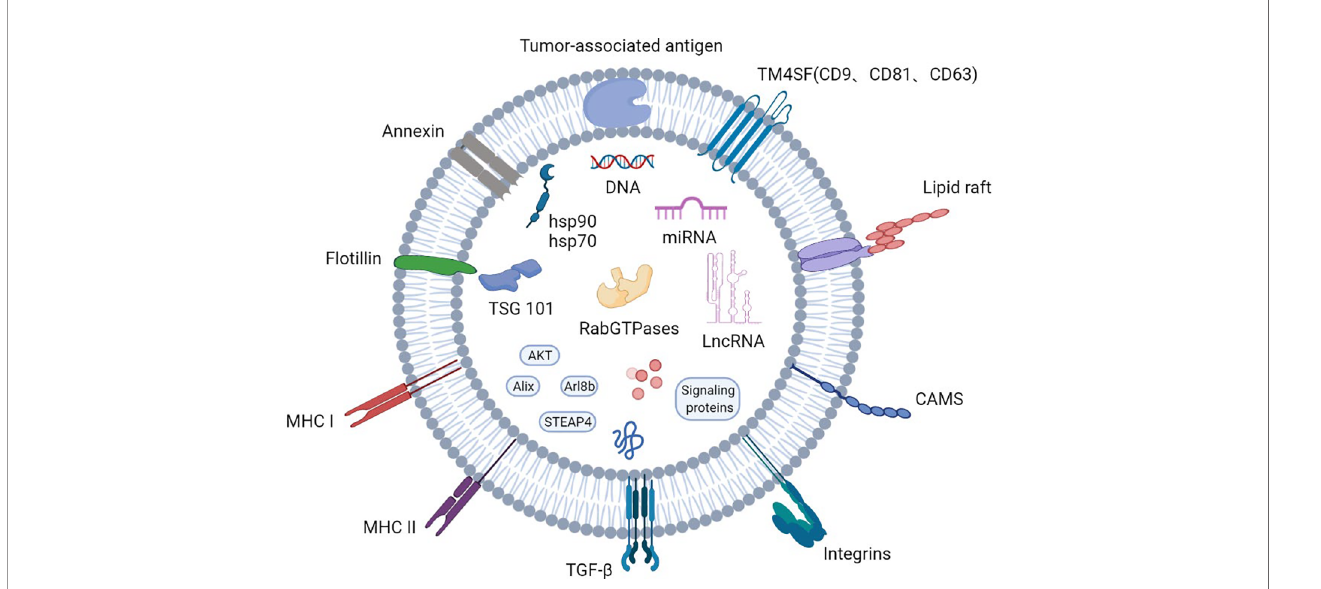
FIGURE 1 | Pro fi le of the basic structure of